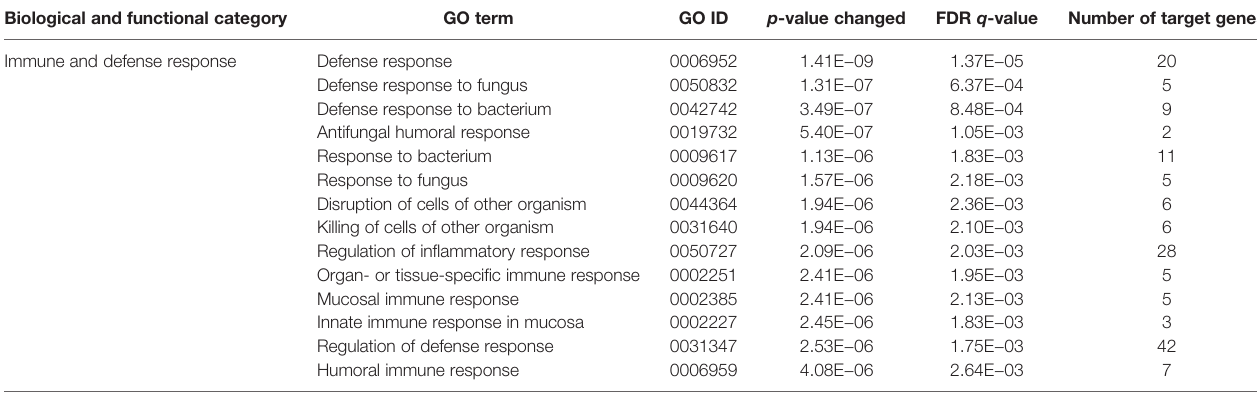
TABLE 2 | GO term analysis and identi fi cation of biological and functional processes downregulated in CD11b+CD11c+ MDSCs compared with CD11b+CD11c − MDSCs. Biological and functional category